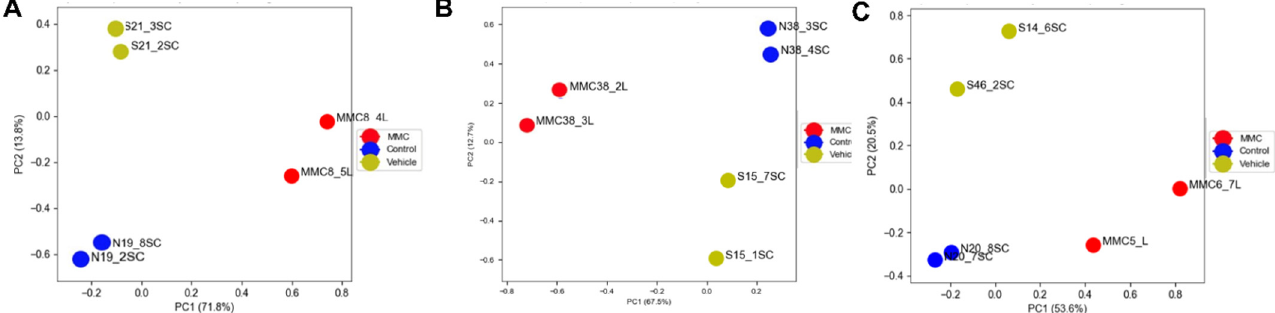
Figure 1. Principal component analysis of libraries sequenced for RNA-seq for tissues isolated at ( A ) E15, ( B ) E17, and ( C ) E20. Table 2. Number of differentially expressed genes identified as >1.5-fold change and p < 0.05 and % of total differentially expressed genes up- or downregulated.